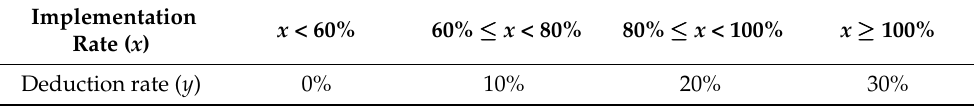
Table 2. The relationship between x and y in the 8-day monthly reduction model.